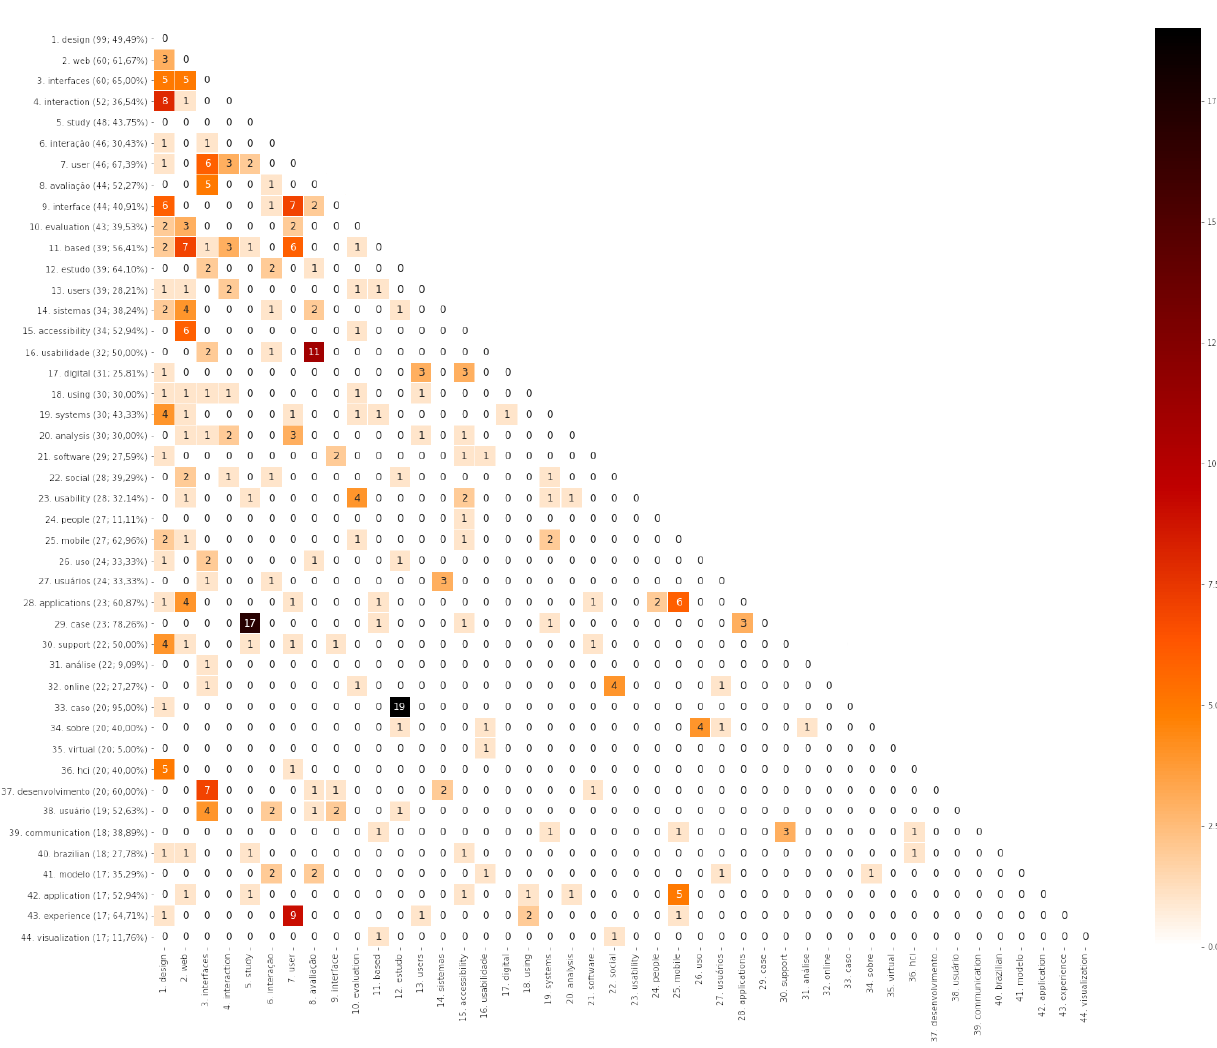
Figure 8. Correlation matrix of the n4 (44) most recurring words from